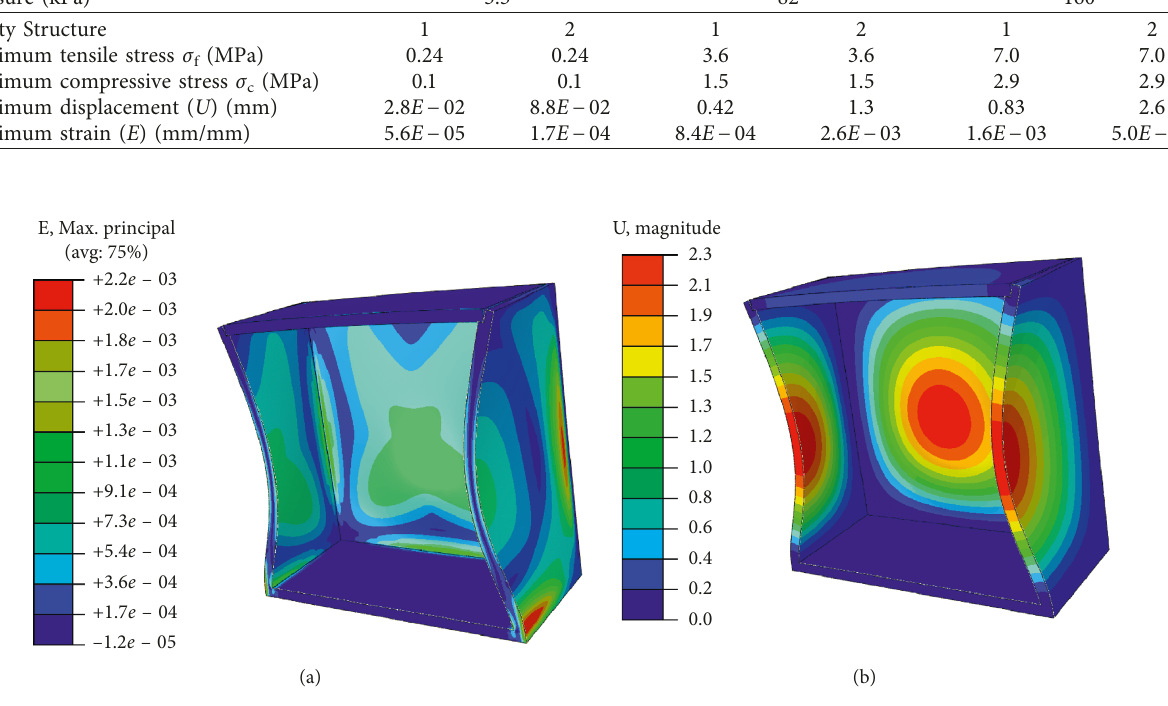
Figure 9: Simulation results of (a) displacement (U) and (b) strain (E) for Utility Structure 1 with a wall thickness of 25mm with a lateral pressure of adjacent soil of 82kPa. Table 8: Simulation results as a function of the wall thickness of Utility Structure 1 and Utility Structure 2 with a pressure of 82 kPa. Thickness (mm) Maximum tensile Maximum displacement ( U ) (mm)